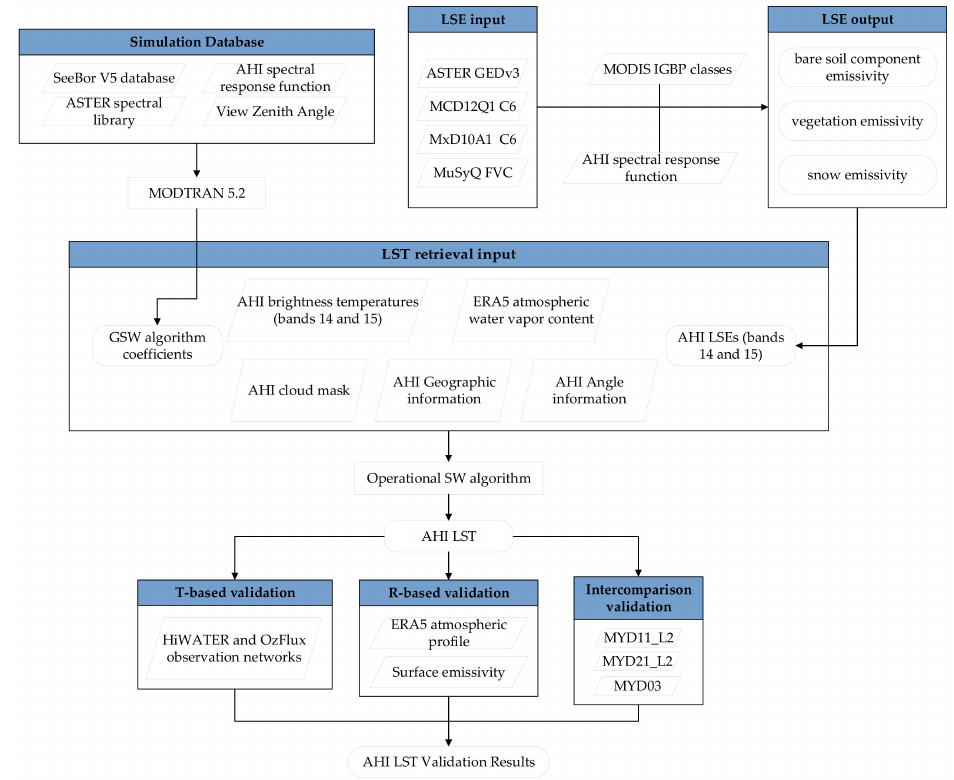
Figure 1. Flowchart of land surface temperature (LST) retrieval and validation from Himawari-8 Advanced Himawari Imager